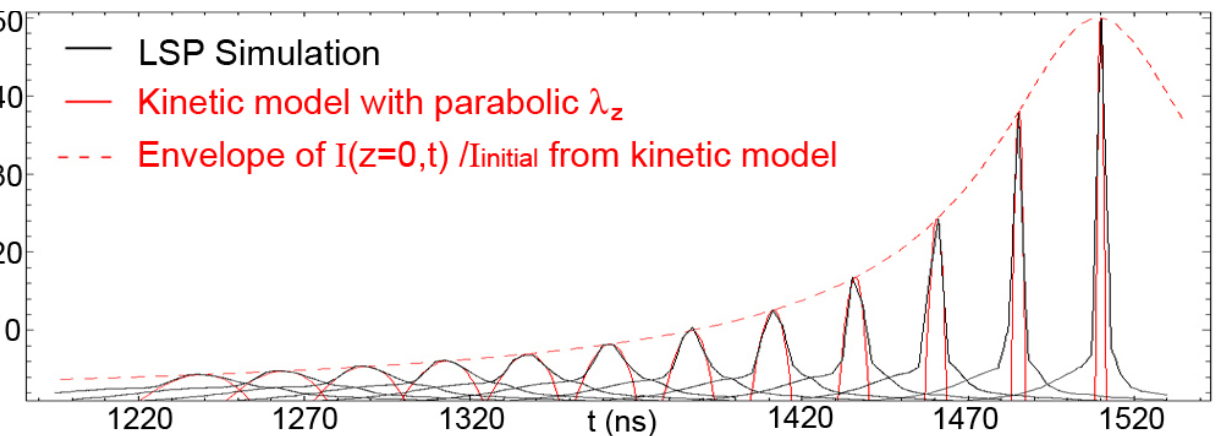
FIG. 7. (Color) Longitudinal compression ratio I (cid:4) t (cid:5) =I in the laboratory frame obtained from the PIC simulation (black) and kinetic initial model (red) at multiple axial locations near the focal plane from Z (cid:8) (cid:2) 77 cm to Z (cid:8) (cid:2) 110 cm